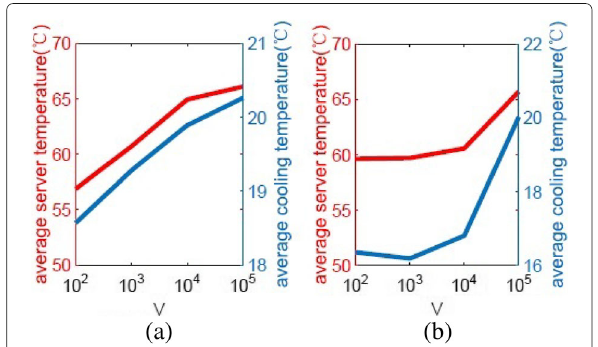
Fig. 10 The average temperature comparison between IT and cooling subsystem. a linear, b quadratic